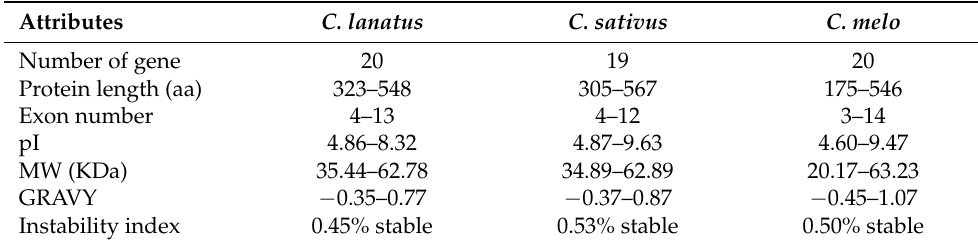
Table 1. Summary of MGTs properties in C. lanatus , C. sativus , and C. melo . Full details are provided in Table